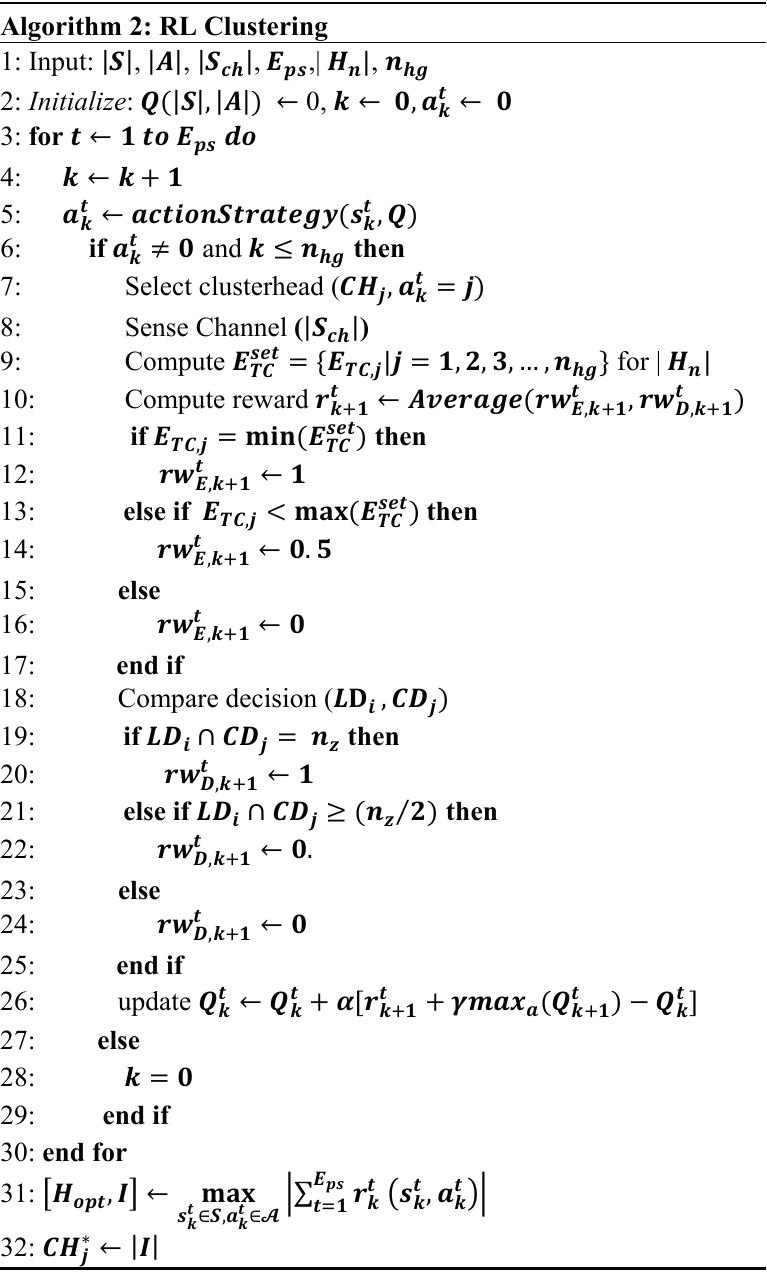
Table 2. Reinforcement learning clustering. Algorithm 2: RL